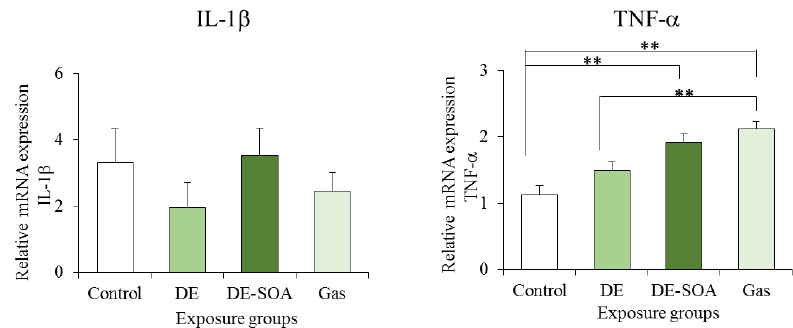
Figure 6. Effects of DE or DE-SOA on the expressions of the proinflammatory cytokine IL- 1β and TNF - α in the hippocampi of the preweaning mice ( n = 6–8, ** p < 0.01 vs. control). 2.5. Effects of DE and DE-SOA on the Histology of the Hippocampus in the Preweaning Mice